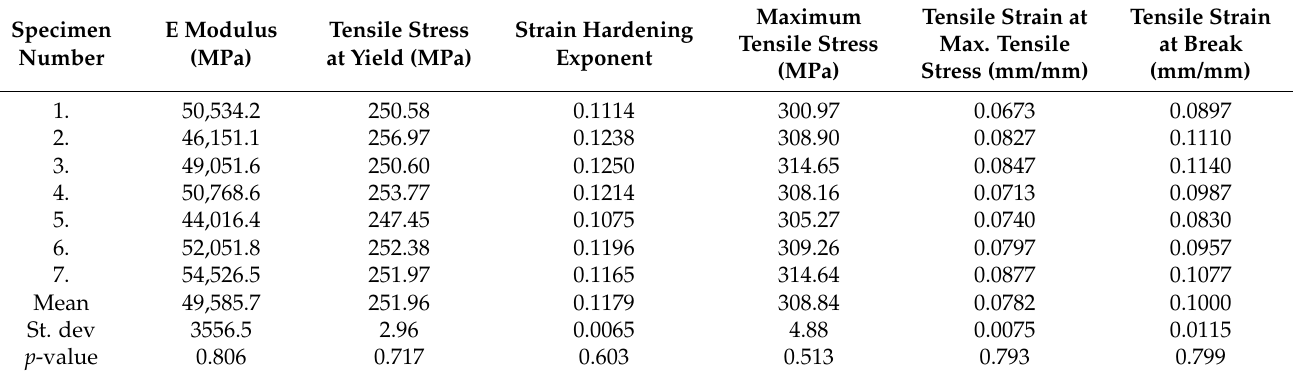
Table 5. Results of uniaxial tensile test for one side welded